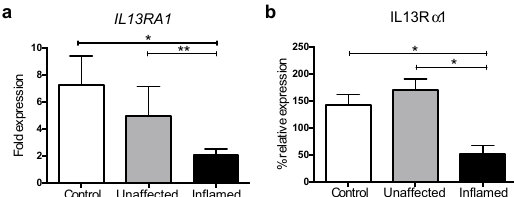
Figure 1. Interleukin-13 receptor α -1 ( IL13RA1 (gene) and IL13R α 1 (protein)) expression is dysregulated in ulcerative colitis (UC): ( a ) Bar graph depicting the mRNA expression of IL13RA1 in colonic biopsies from non-UC patients (Control), unaffected tissue (Unaffected) and their matched inflamed colonic tissue samples taken from the same patient (Inflamed) relative to Control ( n = 11 on each group); and ( b ) Bar graph depicting the relative expression of IL13R α 1 protein in colonic biopsies from non-UC patients (Control), unaffected tissue (Unaffected) and their matched inflamed colonic tissue samples taken from the same patient (Inflamed) relative to Control ( n = 6 for each group). Data were first assessed for normality employing a D’Agostino and Pearson omnibus test when possible. Statistics were then done employing two-sided t -tests for non-parametric data (paired or unpaired): two-sided Mann–Whitney U-tests for non-paired datasets and Wilcoxon matched-pairs signed rank test for paired non-parametric data. Represented are mean + standard error of the mean. *: p -value ≤ 0.05; **: p -value ≤ 0.01.